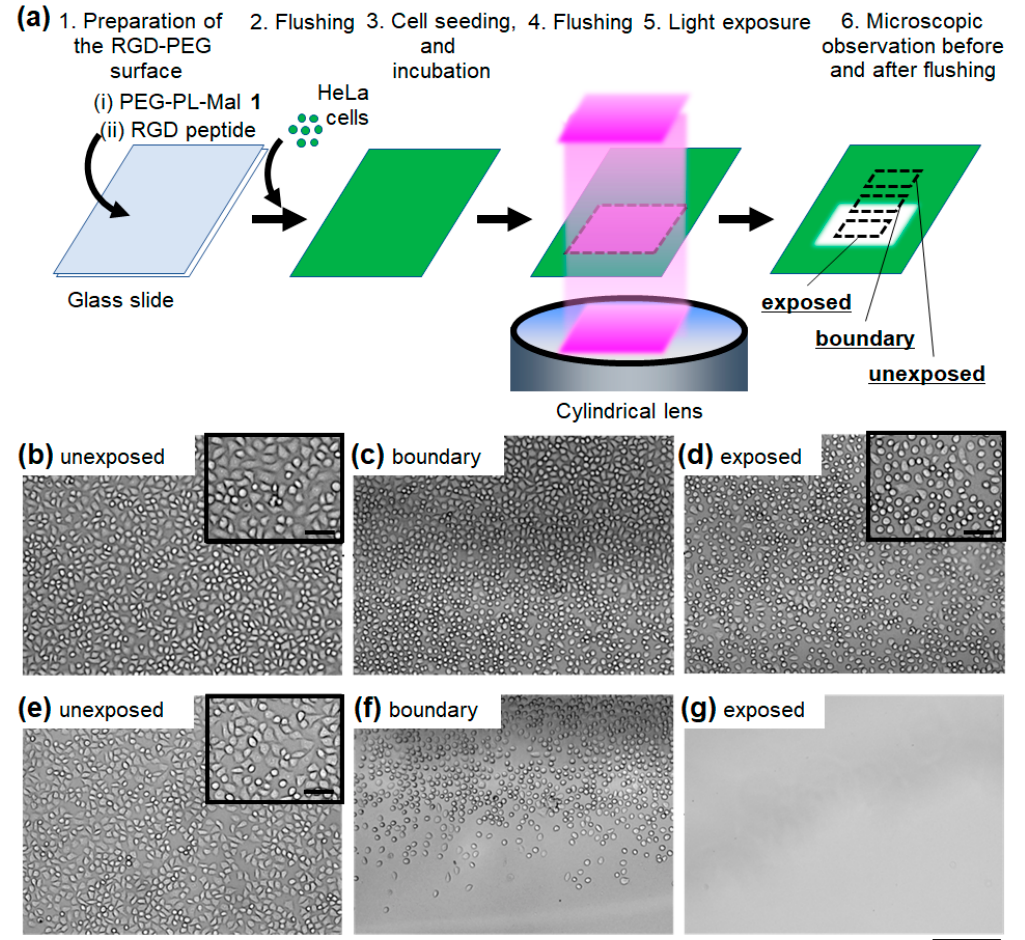
Figure 3. Cell release from the photocleavable RGD-PEG surface exposed to light after cell adhesion. ( a ) Schematic illustration of light-induced cell release. HeLa cells on the surface were observed at the ( b , e ) unexposed region, ( c , f ) the boundary region between the unexposed ( upper ) and exposed regions ( lower ) and ( d , g ) the exposed region. Bright-field microscopic images were obtained ( b – d ) before and ( e – g ) after flushing the detached cells from the surface. Light dose: 4.0 J / cm 2 . Scale bars: 200 µ m. ( inset ) The enlarged images were observed. Scale bars: 50 μ m.